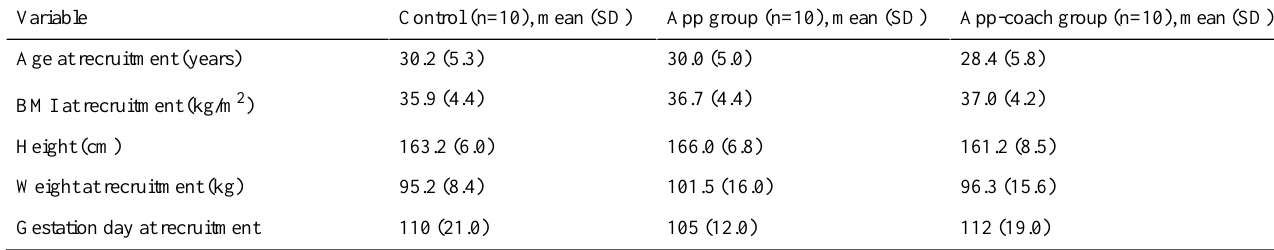
Table 1. Baseline characteristics (total enrolled cohort).